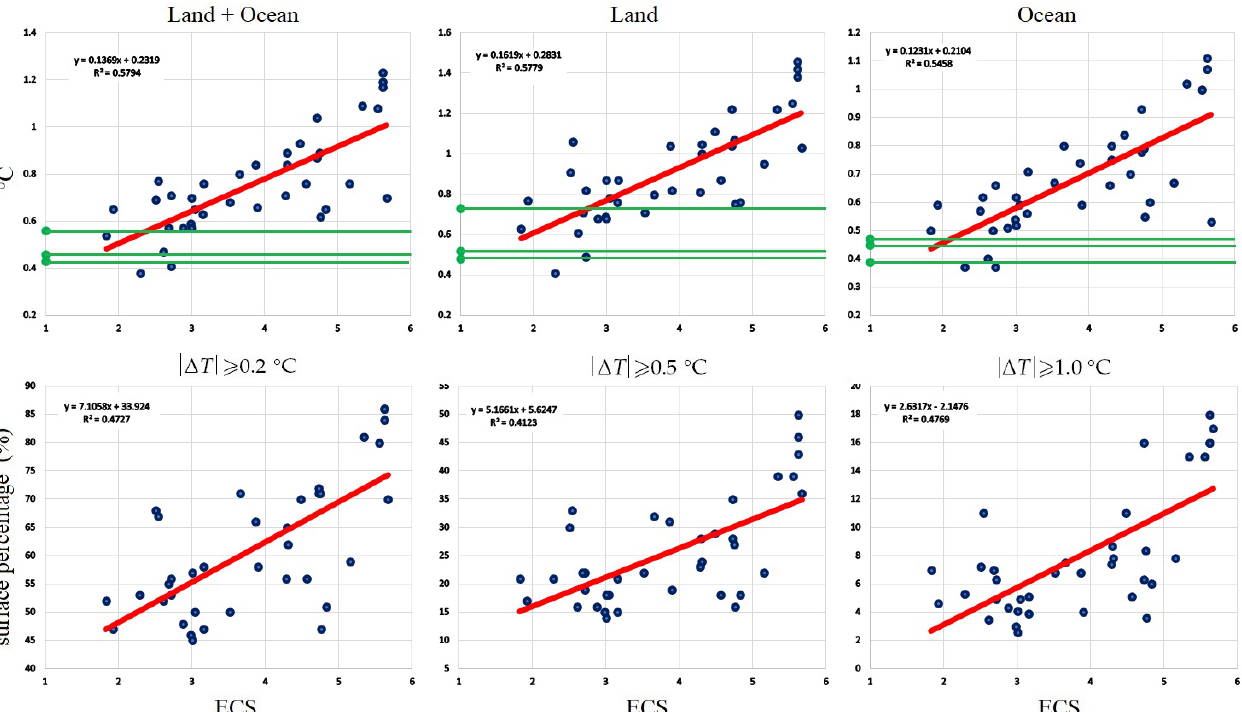
Figure 9. Top panels: scatterplots and linear regressions between the ECS of the mean warming predicted by the CMIP6 GCMs from 1980–1990 and 2011–2021. The green segments represent the warming levels of the temperature data: ERA5- T2m, ERA5-850mb, and UAH MSU v6.0 Tlt. Bottom panels: scatterplots and linear regressions between the ECS of the CMIP6 GCMs and their percentage of the world area where the disagreement with the ERA5-T2m record is | ∆ T | (cid:62) 0.2 °C, | ∆ T | (cid:62) 0.5 °C and | ∆ T | (cid:62) 1.0 °C, respectively. See Table